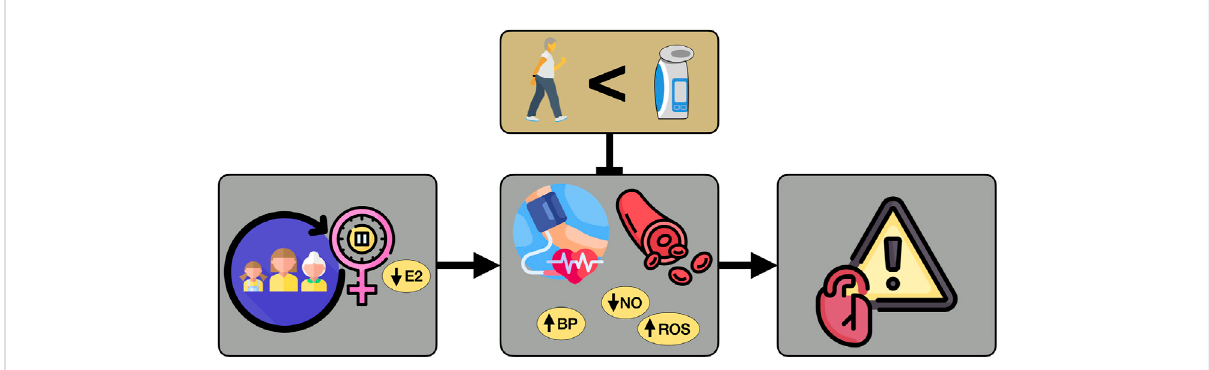
FIGURE 1 Hypothesis. Hypothesized effects of high-resistance inspiratory muscle strength training for lowering systolic blood pressure and improving endothelial function to a greater extent than guideline-based moderate-intensity aerobic exercise in estrogen-de fi cient postmenopausal women. E2, estrogen; BP, blood pressure; NO, nitric oxide; ROS, reactive oxygen species.